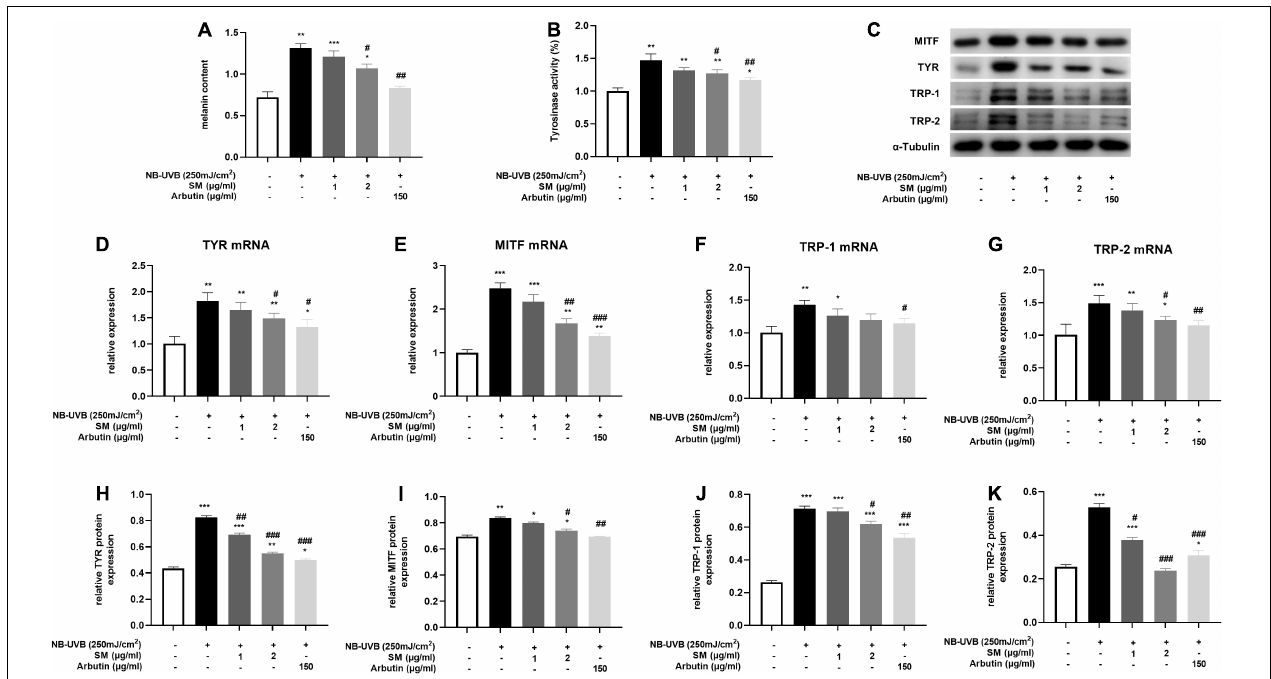
FIGURE 3 | Solamargine (SM) Inhibited UVB-induced melanogenesis in HEM cells. (A) Melanin content of HEM cells 48 h after the UVB irradiation with SM or arbutin treatment. (B) Tyrosinase activity of HEMs 24 h after the UVB irradiation with SM or arbutin treatment. Tyrosinase activity is presented as a percentage of control. Real-time PCR (24 h after incubation with SM) and Western Blot (48 h after incubation with SM) demonstrated SM attenuated UVB-induced secretion of melanogenic factors, TYR (C) Western blot assay of MITF, TYR,TRP-1 and TRP-2 after UVB exposure with/without SM or arbutin treatment. (D,H) , MITF (E,I) , TRP-1 (F,J) , and TRP-2 (G,K) in HEM cells. Treatment with SM after UVB irradiation significantly decreased the mRNA and protein levels of TYR, MITF, TRP-1, and TRP-2. The anti-melanogenesis effect of SM is comparable to 150 µ g/ml Arbutin. The data represent the mean ± S.D. from three independent experiments. * P < 0.05, ** P < 0.01, *** P < 0.001 (vs. non-treated group); # P < 0.05, ## P < 0.01, ### P < 0.001 (vs. NB-UVB irradiated